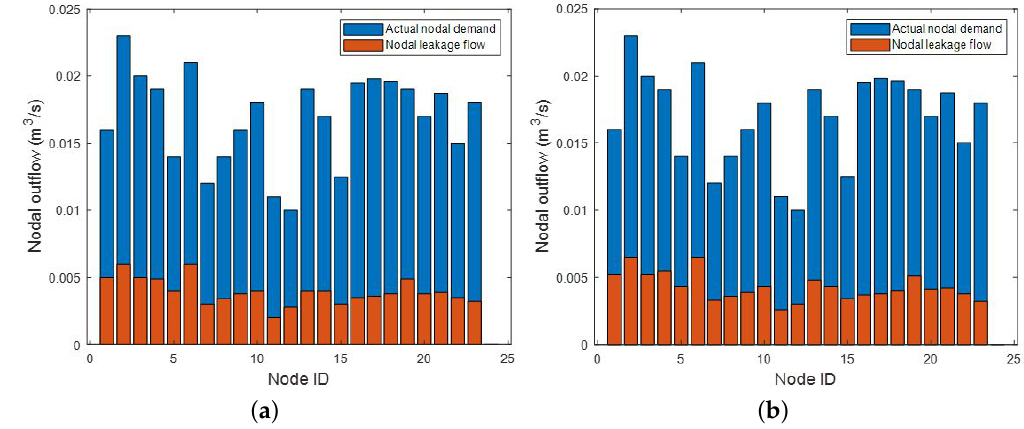
Figure 2. Nodal demand vs. the leakage flow for each node for the case study network 1: